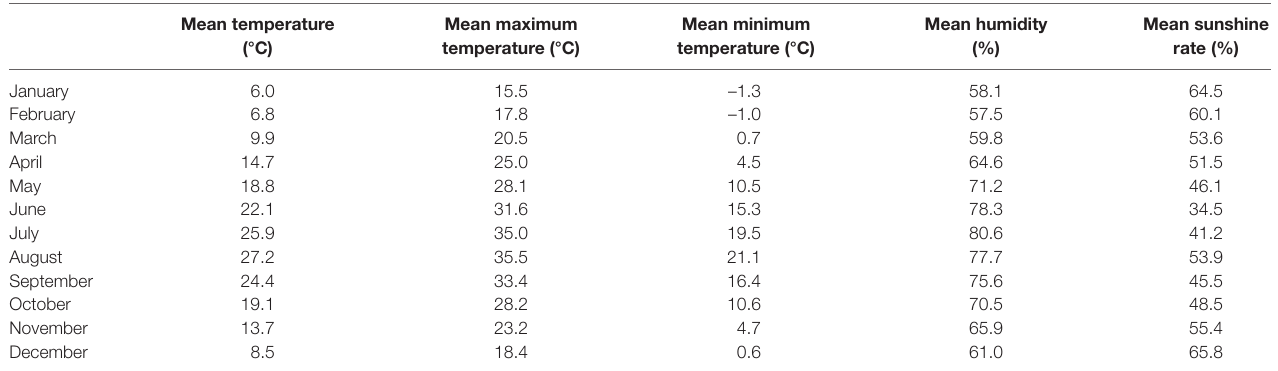
TaBle 5 | Monthly change in temperature, humidity, and sunshine rate from 1985 to 2015 in hamamatsu, Japan (25). Mean temperature (°c)